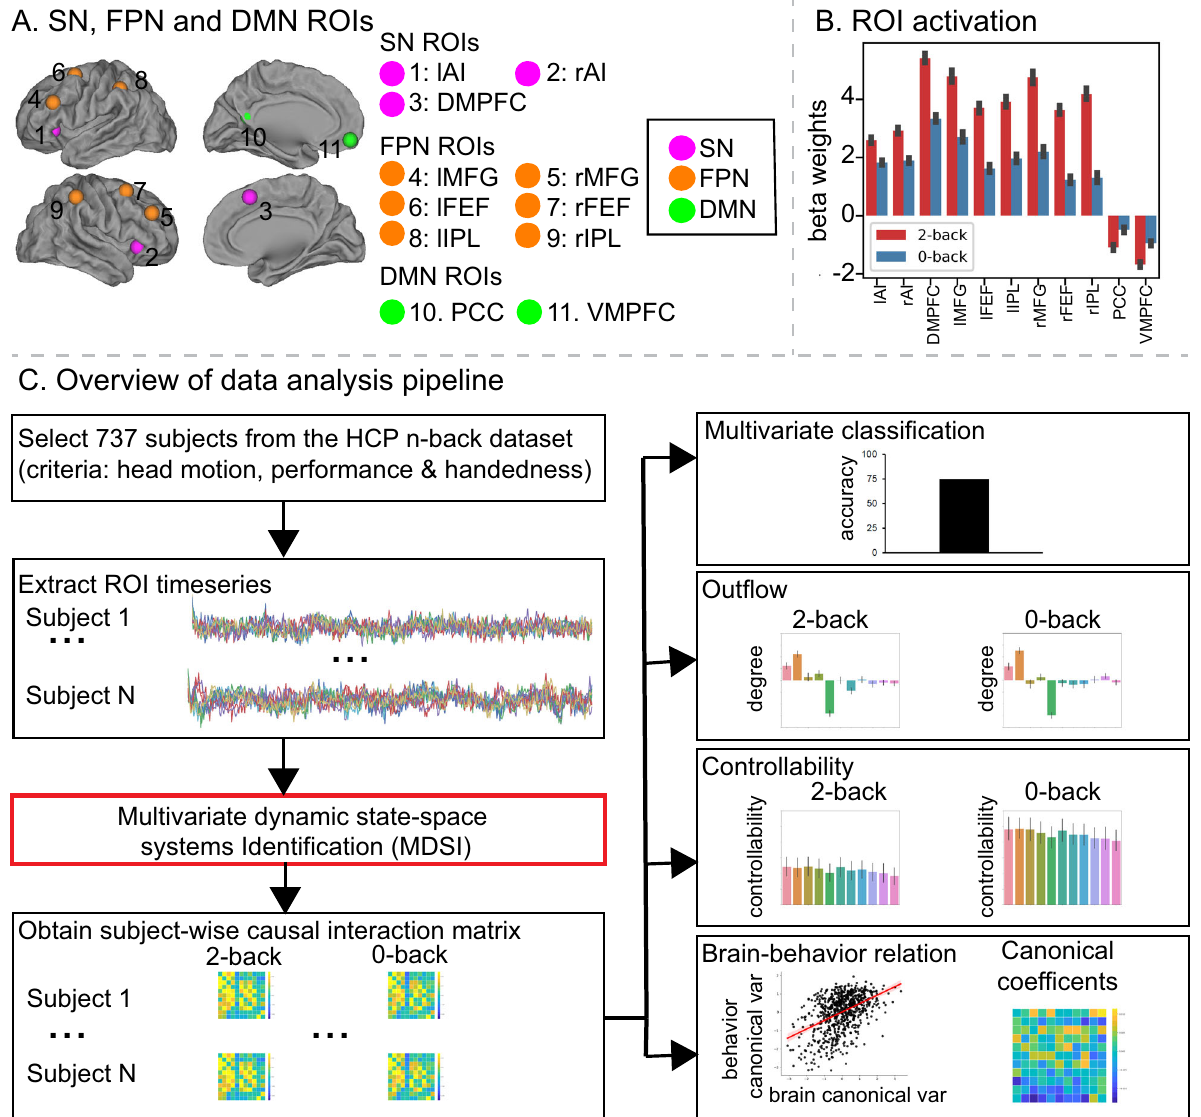
Fig. 1 Schematic illustration of data analysis strategy and procedures. A Salience Network (SN), Frontal-Parietal Network (FPN), and Default Mode network (DMN) ROIs: (1) left anterior insula (lAI); (2) right anterior insula (rAI); (3) dorsomedial prefrontal cortex (DMPFC); (4) left middle frontal gyrus (lMFG); (5) right middle frontal gyrus (rMFG); (6) left frontal eye fi eld (lFEF); (7) right frontal eye fi eld (rFEF); (8) left intraparietal lobule (lIPL); (9) right intraparietal lobule (rIPL); (10) posterior cingulate cortex (PCC), and (11) ventromedial prefrontal cortex (VMPFC). B General linear model analysis revealed signi fi cant working-memory-load-related activation in SN and FPN (task-positive nodes), and deactivation in the DMN (task-negative nodes) ( p < 0.01, FDR-corrected, two-sided t -test). N = 737 participants. Data are presented as mean ± SEM. C Overview of data analysis pipeline. We fi rst screened the HCP n-back working-memory dataset based on head motion, behavioral performance, and participant handedness. We then extracted time series from each of the 11 ROIs and applied MDSI to determine working-memory load-speci fi c dynamic causal interactions from each participant in the 2-back and 0- back task conditions. MDSI-derived causal in fl uences were then used to investigate (1) whether multivariate dynamic causal interaction patterns distinguished 2-back versus 0-back task conditions, (2) task-dependent causal out fl ow from each ROI, (3) network controllability as a function of working- memory load, and (4) the relationship between the strength of dynamic causal interactions and behavioral performance. HCP human connectome